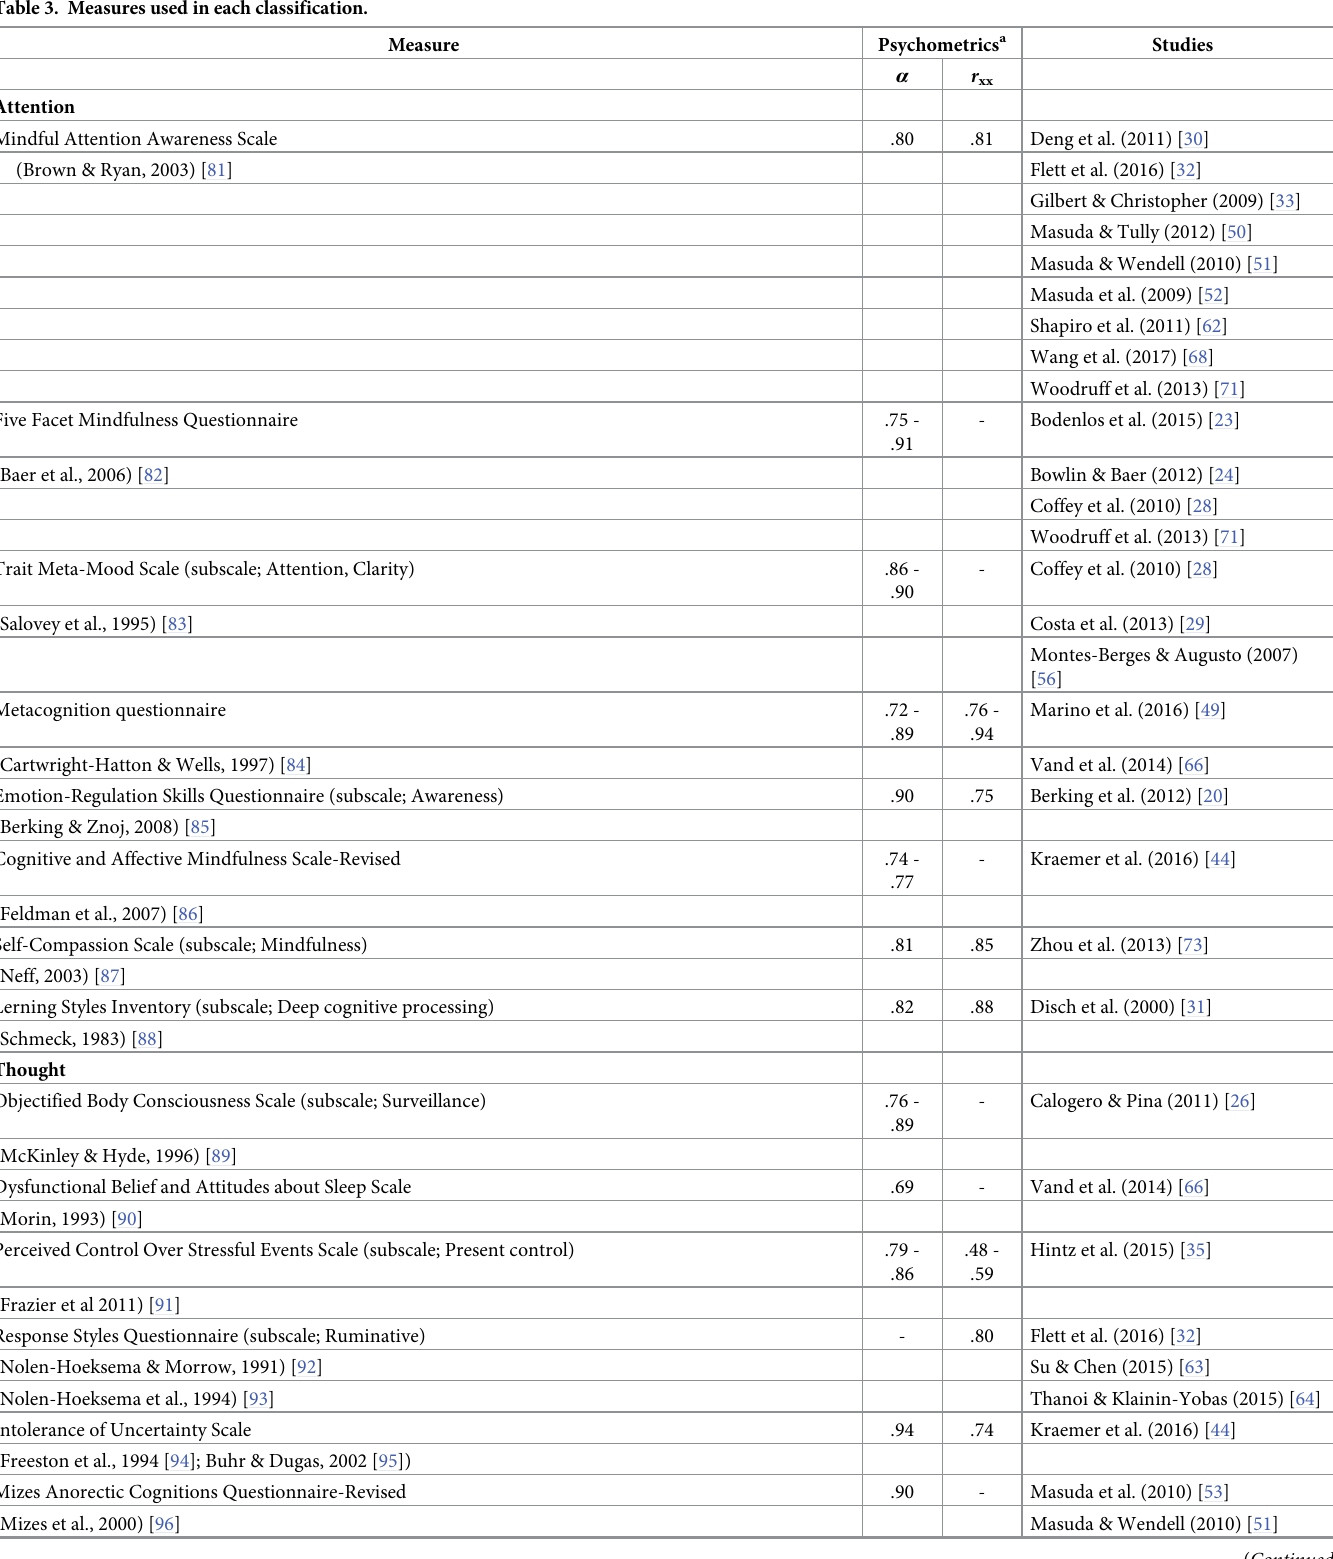
Table 3. Measures used in each